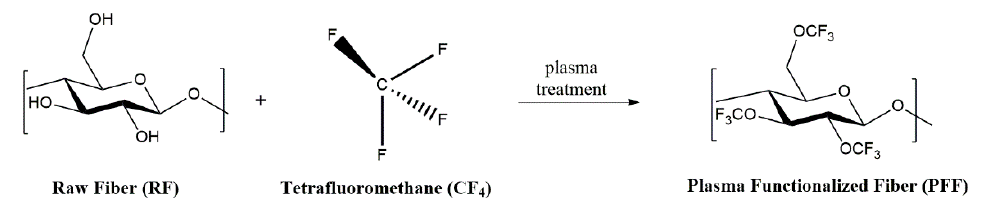
Figure 2. Scheme of the cellulose functionalization reaction by means of low-pressure plasma technique.